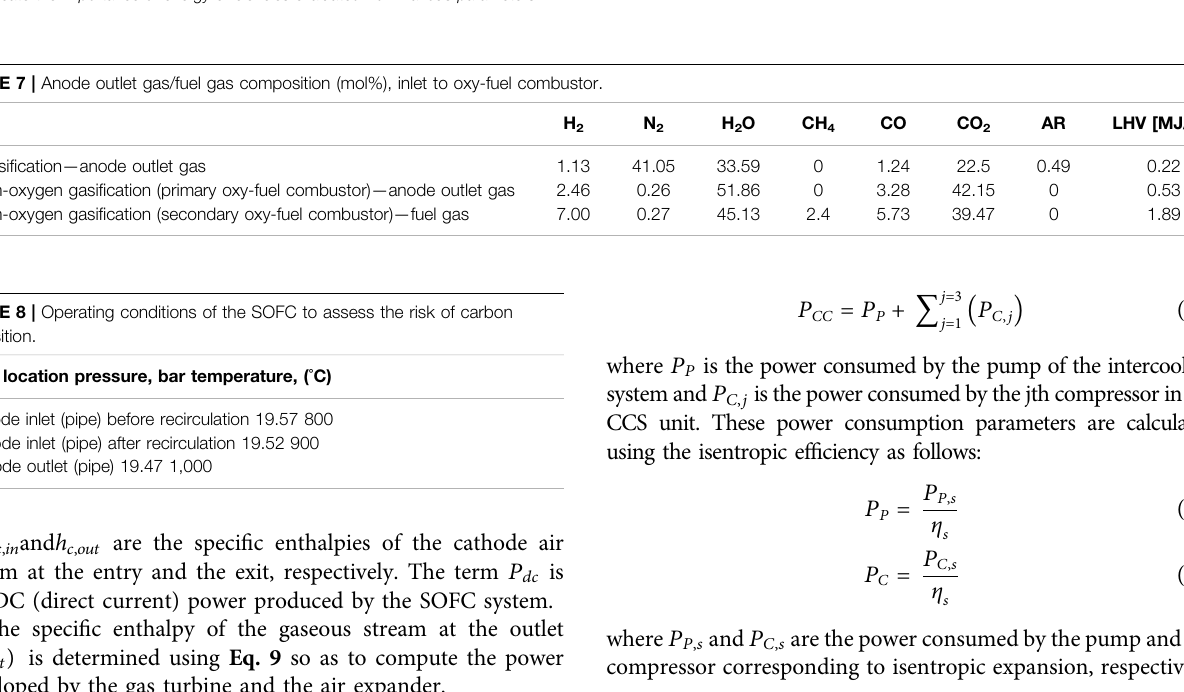
To indicate the importance of energy ef fi ciencies evaluated from various parameters.